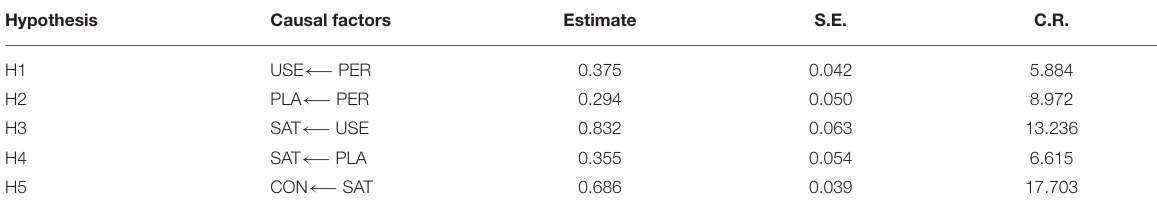
TABLE 4 | Path coefficient analysis